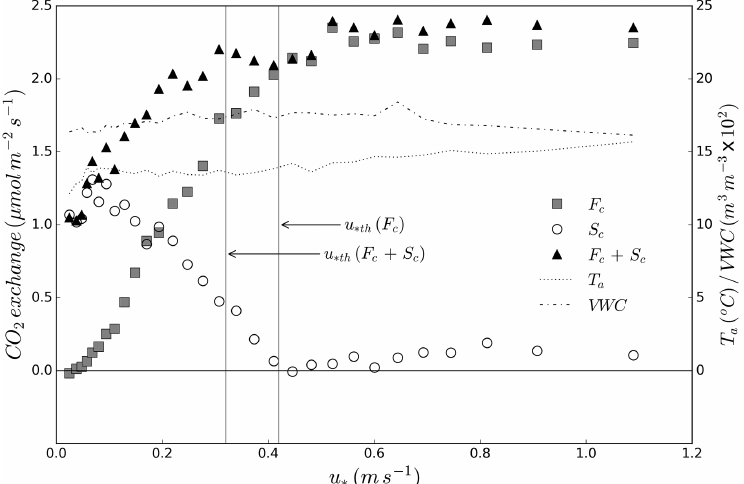
Figure 5. (LH axis) dependence of mean measured nocturnal carbon mass balance components (turbulent flux ( F c ), storage ( S c ) and F c + S c ) on friction velocity ( u ∗ ) ; (RH axis) air temperature at EC instrumentation height (36m) and volumetric soil moisture content at 10cm. Vertical lines denote u ∗ th for both F c and F c + S c , as